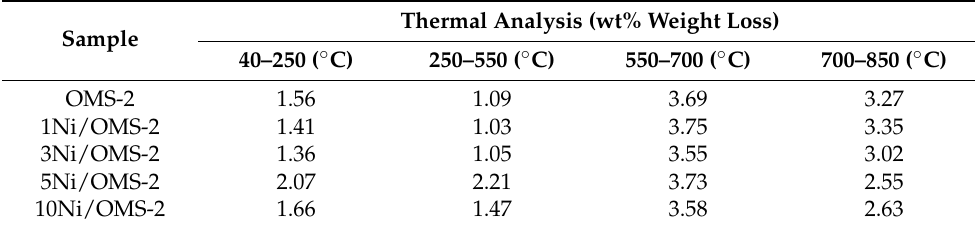
Figure 5. Figure 5. TGcurves of ( a ) OMS-2, ( b ) 1Ni/OMS-2, ( c ) 3Ni/OMS-2, ( d ) 5Ni/OMS-2, and ( e ) 10Ni/OMS-2. Table 1. Thermal analysis of the OMS-2 and x Ni/OMS-2 Table 1. Thermal analysis of the OMS-2 and x Ni/OMS-2 samples.